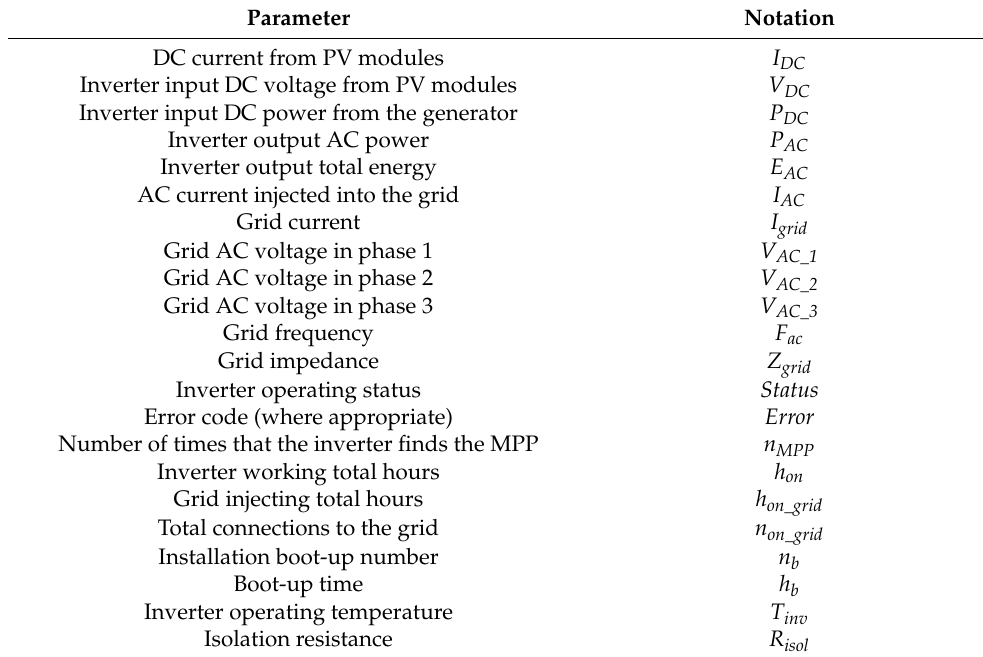
Table 2. Parameters generally measured by